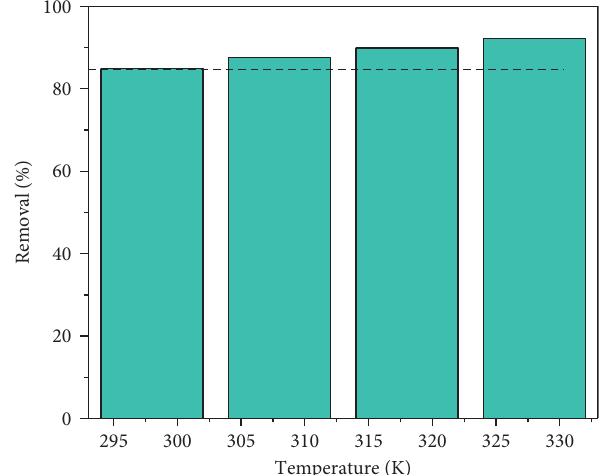
Figure 9: Effect of temperature on the RBB